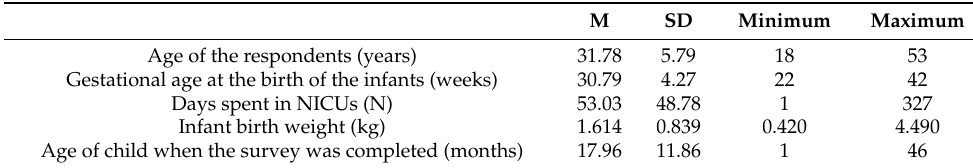
Table 1. Descriptive statistics of the sample (parents and infants).